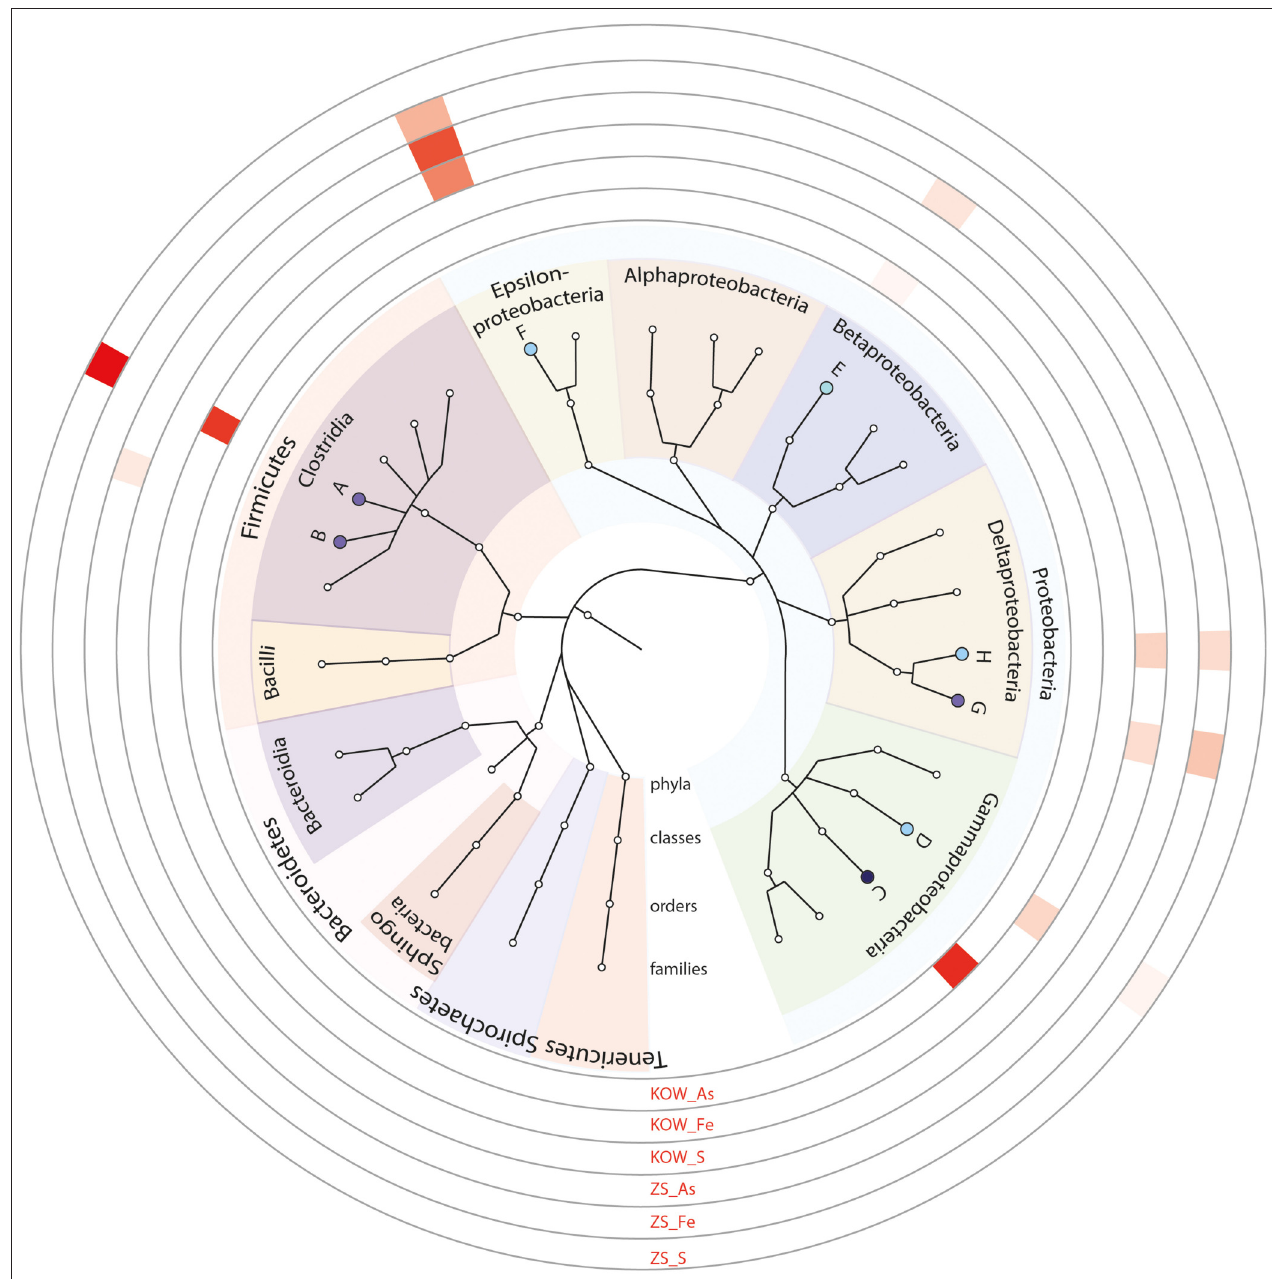
FIGURE 8 | Most abundant genera found in consortia using 16S rRNA amplicon sequencing. On the outer ring, family abundances in individual consortia are showed as a heatmap. A, Lachnospiraceae ; B, Eubacteriaceae ; C, Shewanellaceae ; D, Enterobacteriaceae ; E, Rhodocyclaceae ; F, Campylobacteraceae ; G, Desulfomicrobiaceae; H, Desulfovibrionaceae